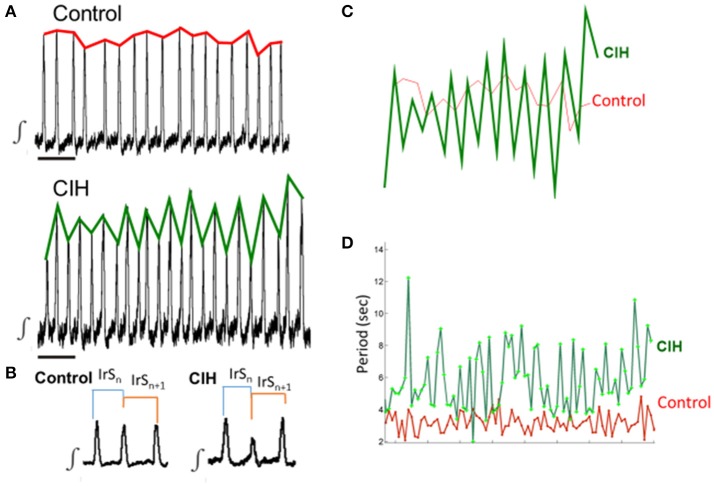
Fluctuations in network parameters can be detected and characterized by different methods. (A) Representative examples of integrated traces of preBötC activity from the control (top) and CIH (bottom) groups. Red line highlights the periodic fluctuation in burst amplitude throughout the control rhythm. Green line highlights the periodic fluctuation in burst amplitude throughout the time-series. Scale bar: 10 s. (B) Expanded traces of representative rhythms from (A) group illustrating the time window for the calculation of irregularity score (IrS) for the nth and the nth+1 cycles (i.e., the burst to burst window) for both control and CIH rhythms. (C) Overlay of the fluctuation of burst amplitudes for the control rhythm in (A) (red) and the CIH rhythm in (B) (green) demonstrating the presence of fluctuations in both rhythms yet larger in magnitude in the CIH group. The gain of fluctuations can be described by the fluctuation value (χ) see methods for formula. (D) Example of the fluctuation of period for a control rhythm (red) and a CIH rhythm (green). Representative integrated traces showing the fluctuations in period can be observed in Figure 2, 4.